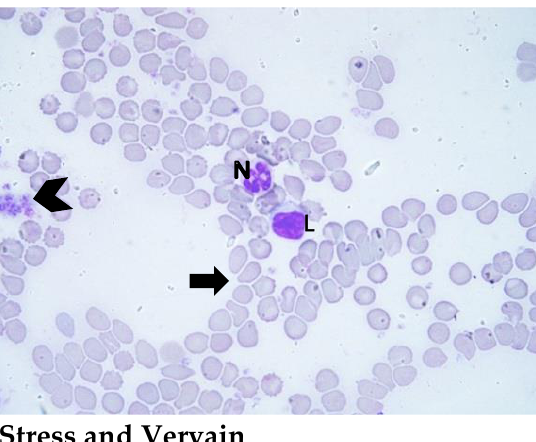
Figure 2. Representative blood smears of animals in each experimental group, Wright ’ s stain A t = 400×. Arrowhead (platelets), N (neutrophils), L (lymphocytes), Arrow (erythrocytes).